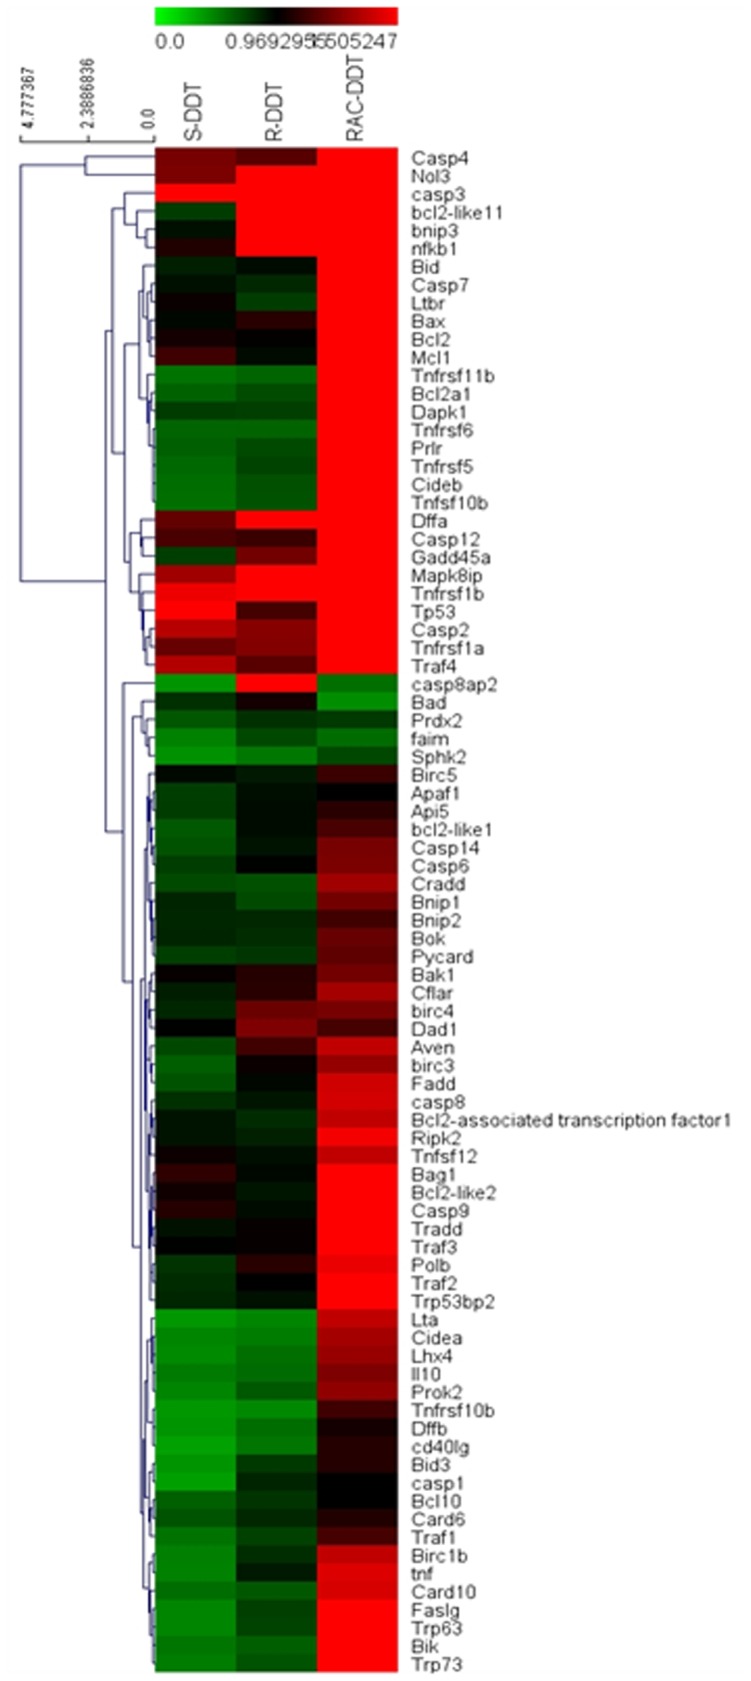
Heatmap of 84 apoptotic genes.The hierarchical clustering was performed for microarray data. Green indicates relative low expression, and red indicates relative high expression.